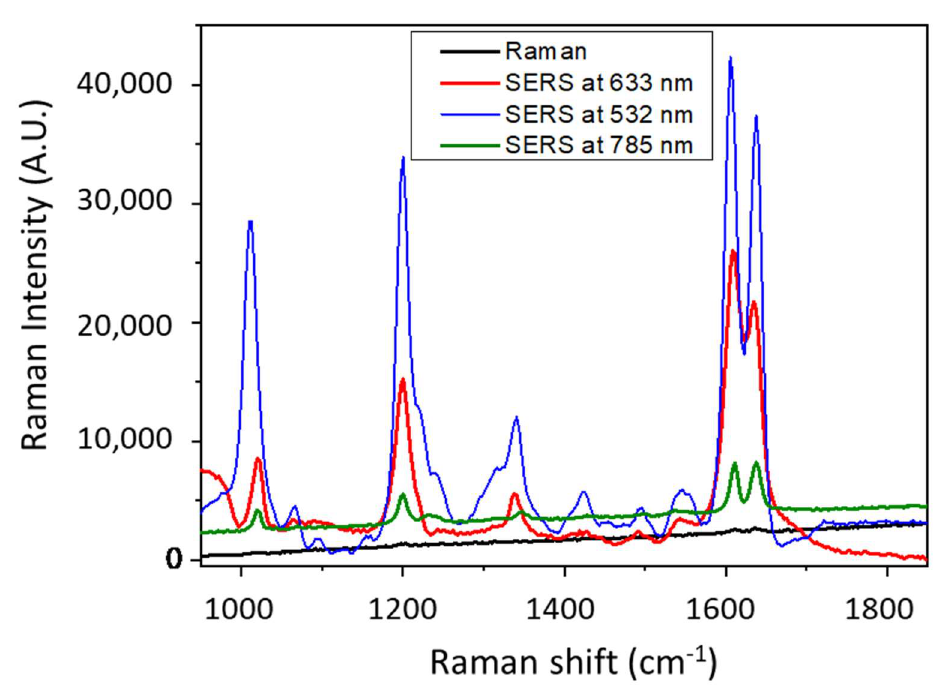
Figure 9. SERS spectra of 10 − 20 M of BPE probed at different wavelength for the sample shown in Figure 8. Raman measurements were obtained with 10 − 2 M of BPE. Spectra were obtained at P = 10 mW over 10 s. Each curve is an average of 10 spectra collected from different positions on the substrate.